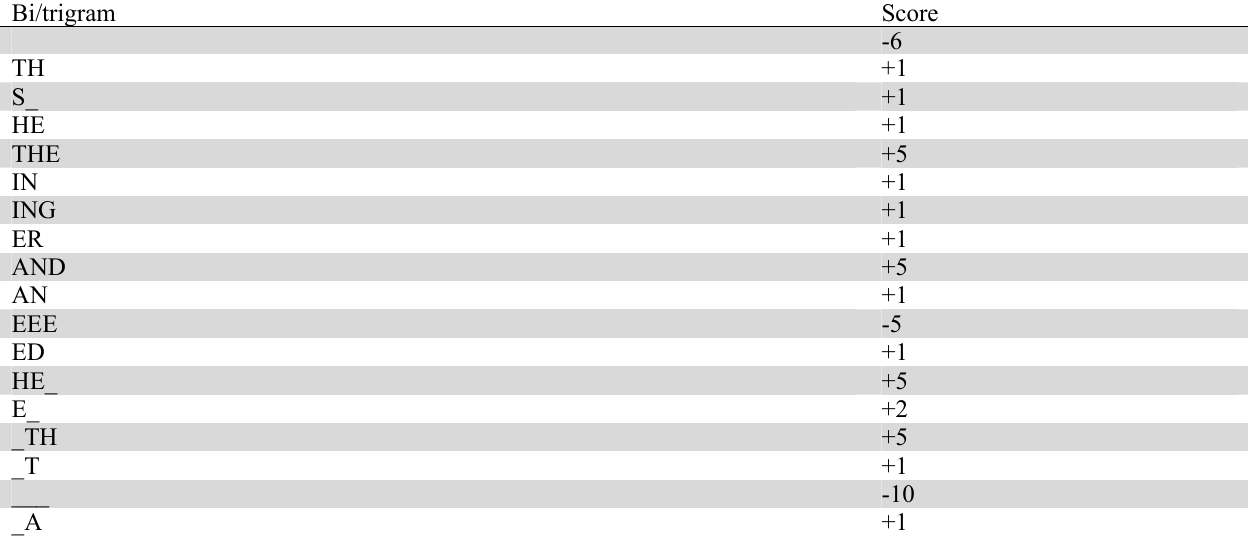
Reformed weights by Clark (1998a, 1998b) Bi/trigram Score